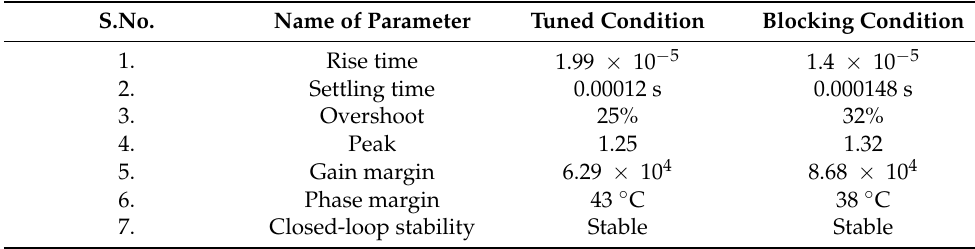
Table 3. Steady-state parameters of boost convertor.